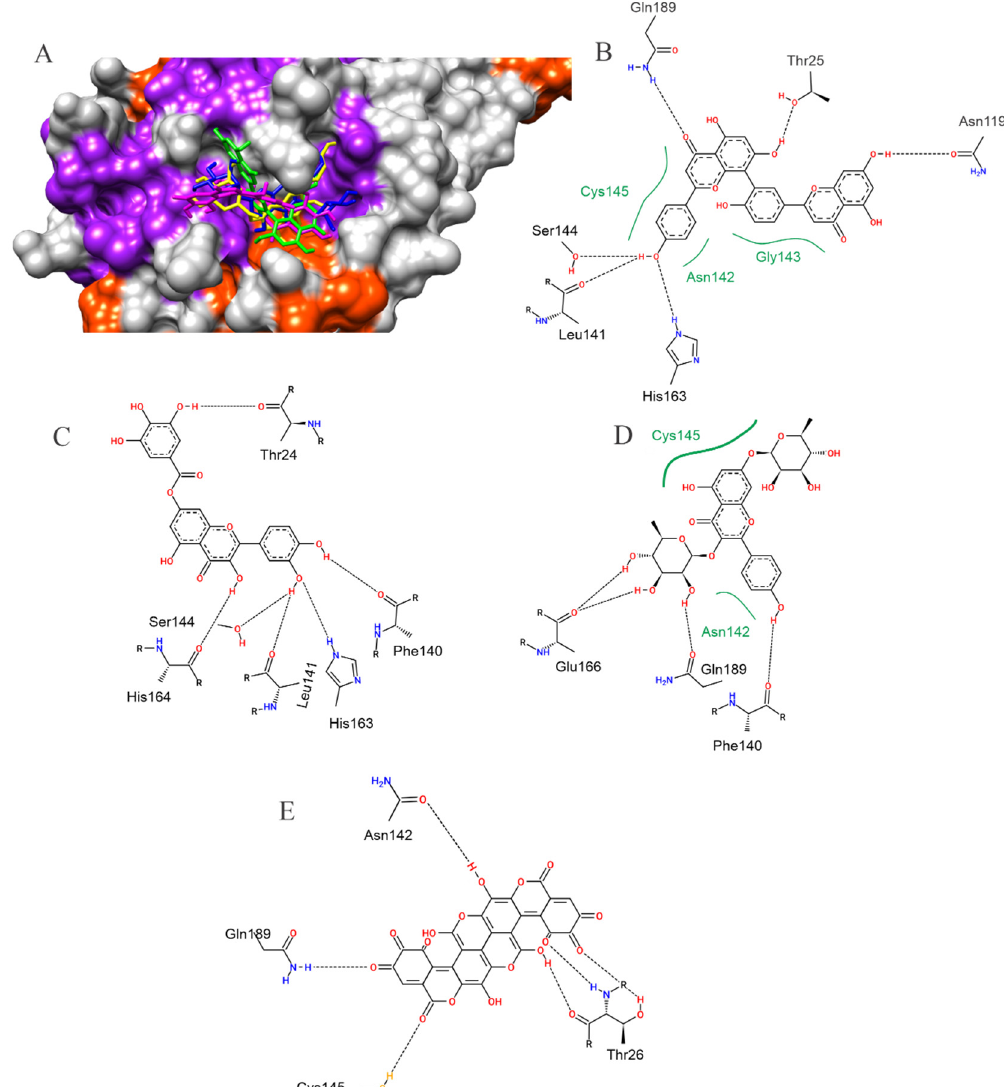
Figure 2. The surface representation of plant metabolites docking positions on the SARS-CoV-2 Mpro active site is shown, with amentoflavone (green), kaempferitrin (blue), 7-O-galloylquercetin (yellow), and gallagic acid (magenta) ( A ). Contacts of SARS-CoV-2 Mpro active site residues with amentoflavone ( B ), 7-O-galloylquercetin ( C ), kaempferitrin ( D ), and gallagic acid ( E ) are depicted in a two-dimensional diagram. Dashed black lines indicate hydrogen bonds; full green lines indicate van der Waals interactions.